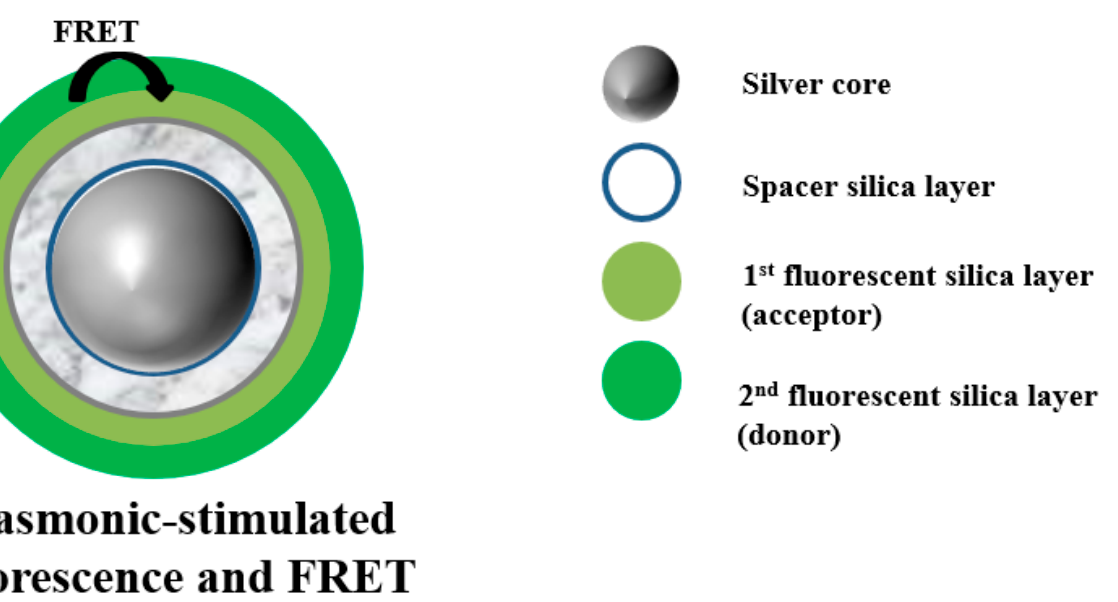
Figure 9. Schematic representation of fluorescence and FRET excited by plasmon. Adapted from Ref. [72].